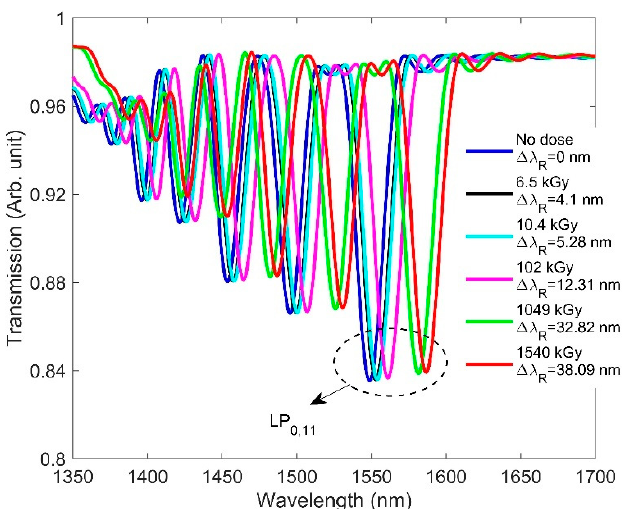
Figure 6. RIC effects on the transmission spectrum of the designed LPG along with the resonance wavelength shift ( ∆ λ R ) for the LP 0,11 cladding mode when dose is increased from 0 to 1540